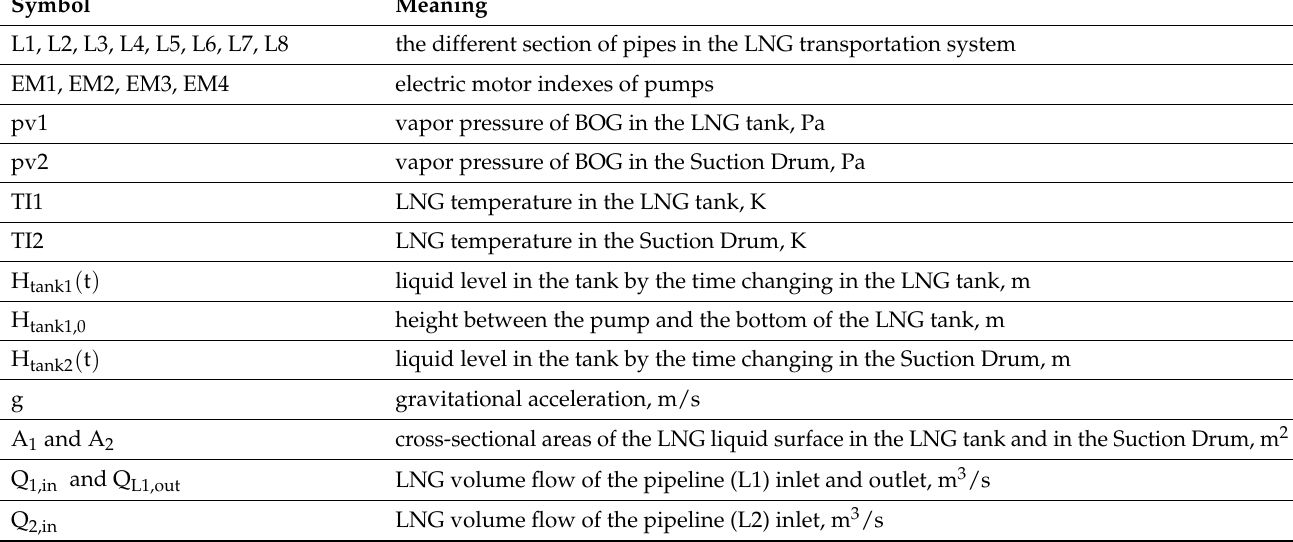
Table 1. Symbols and